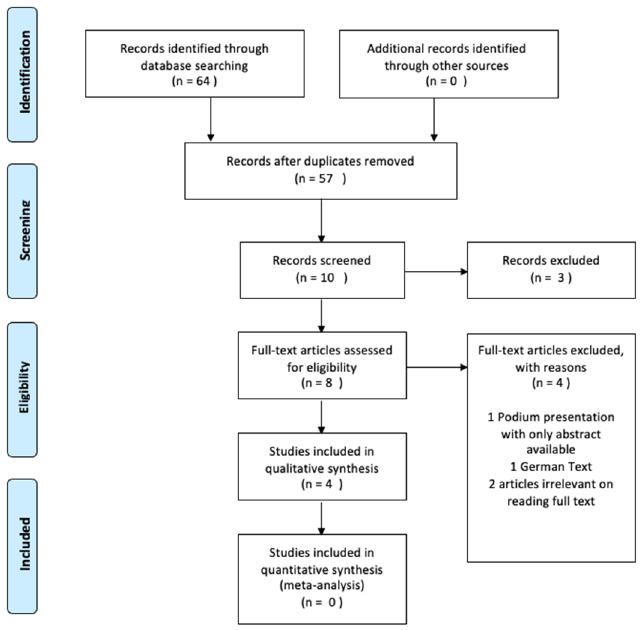
Figure 1. Prisma Flow